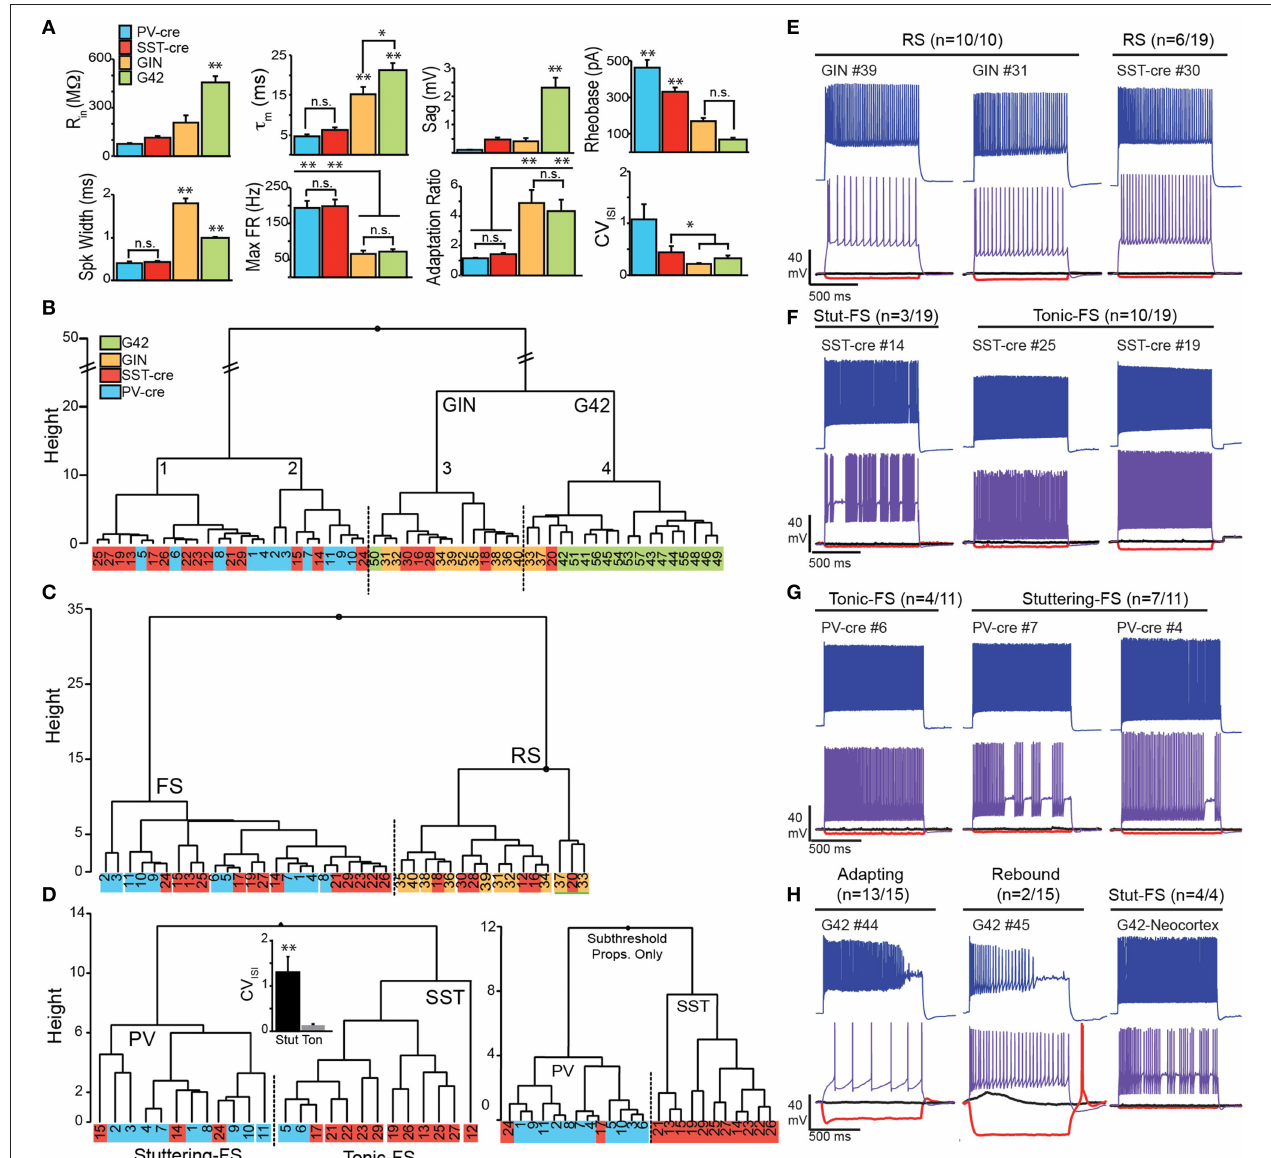
FIGURE 5 | Electrophysiological properties SST and PV cells in Cre, GIN, and G42 lines. (A) Comparisons of subthreshold ( R in , input resistance; τ m , time constant; Sag) and suprathreshold electrophysiological properties (Rheobase, spike width, maximum firing rate, adaptation ratio, and CV ISI : coefficient of variation of the interspike interval) in target neurons from anterior piriform cortex in SST-cre (red), PV-cre (blue), GIN (yellow), and G42 (green) mice. Statistical significance assessed using ANOVA-Tukey for multiple comparisons (* p < 0.05; ** p < 0.01, n.s., not significant). (B) Clustering of all interneurons using the eight electrophysiological parameters in (A) . (C) Clustering of SST-cre cells (red) as fast spiking (FS) with PV-cre (blue) or regular spiking (RS) with GIN (yellow) cells using eight parameters, in the absence of G42 cells. (D) In the absence of RS cells, FS cells cluster as either PV-cre or SST-cre with minimal error (five cells) using eight parameters (left). CV ISI (inset) significantly differs between stuttering FS-cells (mainly PV) and tonic FS cells (mainly SST; p < 0.01, unpaired t -test). SST-cre and PV-cre cells cluster with even less error (right, two cells) when only three subthreshold properties ( R in , τ m , and Sag) are used. (E) Examples of RS SST cells in SST-cre and GIN mice. Numbers correspond to individual cells in clustering diagrams (B–D) . (F) Examples of FS SST-cre exhibiting both stuttering (Stut-FS) and tonic-FS responses. (G) Examples of FS PV-cre cells exhibiting both stuttering (Stut-FS) and tonic-FS responses. (H) Left, Examples of G42 cells recorded in APC showing unusual adapting and/or rebound responses. Right, Example of G42 cell recorded in neocortex showing classic stuttering-FS